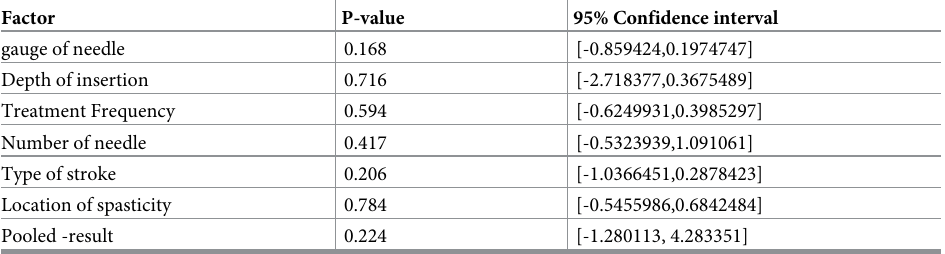
Table 7. Result of